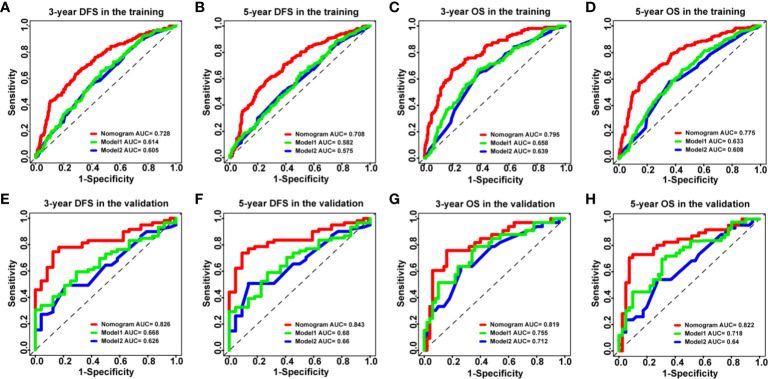
The ROC curves of the nomogram models and other models in HCC patients. (A–D) ROC curves showing the discriminatory abilities of the nomogram models and other models for the 3-year DFS (A) and OS (C) rates and 5-year DFS (B) and OS (D) rates in the training cohort. (E–H) ROC curves showing the discriminatory abilities of the nomogram models and other models for the 3-year DFS (E) and OS (G) rates and 5-year DFS (F) and OS (H) rates in the validation cohort. GPR, gamma‐glutamyl transpeptidase‐to‐platelet ratio; ALB, albumin; ROC, receiver operating characteristic; HCC, hepatocellular carcinoma; DFS, disease-free survival; OS, overall survival.